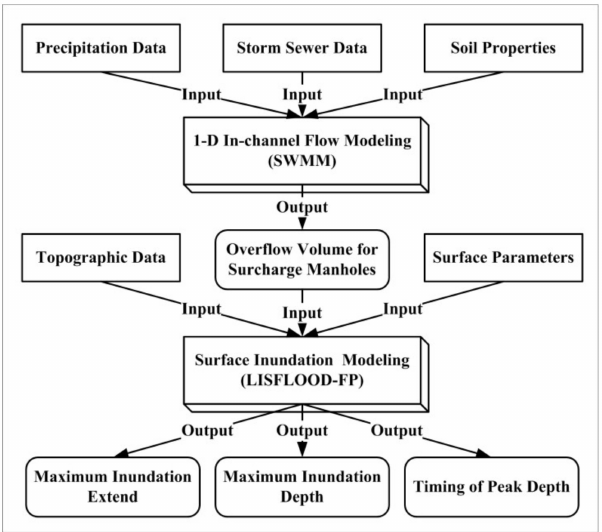
Figure 3. The coupled urban flood inundation simulation model used in this